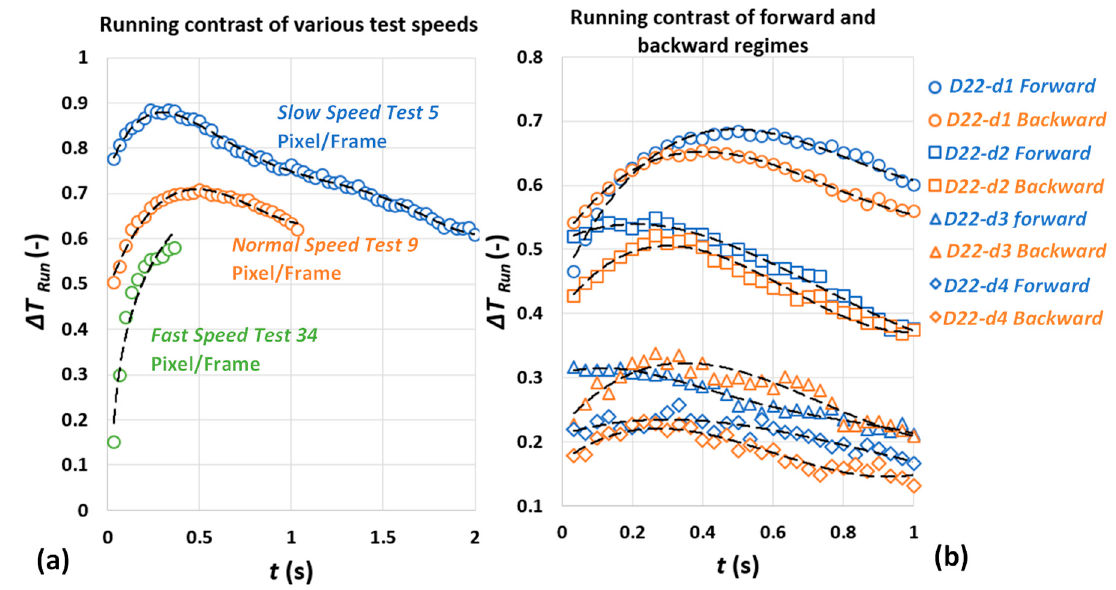
Figure 8. ( a ) Average running contrast of D = 22 mm, d = 1 mm defect for various test speeds; ( b ) average running contrast of D = 22 mm defects with different depths under forward and backward regimes.